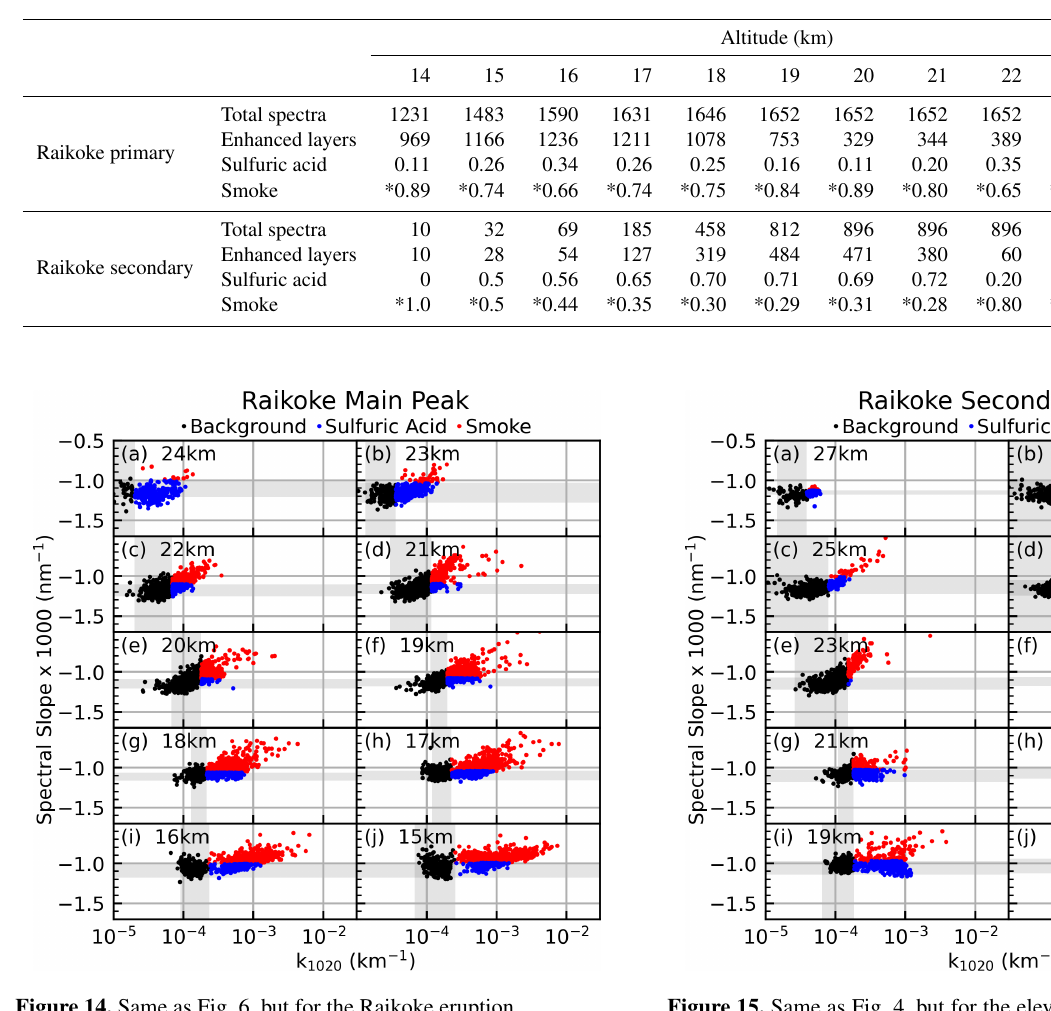
Table 4. Same as Table 3 but for the Raikoke event. As discussed in the main text, the smoke classifications within this table are most likely misclassifications of large sulfuric acid particles and/or ash. For distinction between Raikoke primary and Raikoke secondary, refer to Sect. 6.1. Because of the lack of support for extensive stratospheric smoke during the Raikoke time period the smoke classifications were flagged as being highly probable misclassifications, as indicated by the asterisk (*).